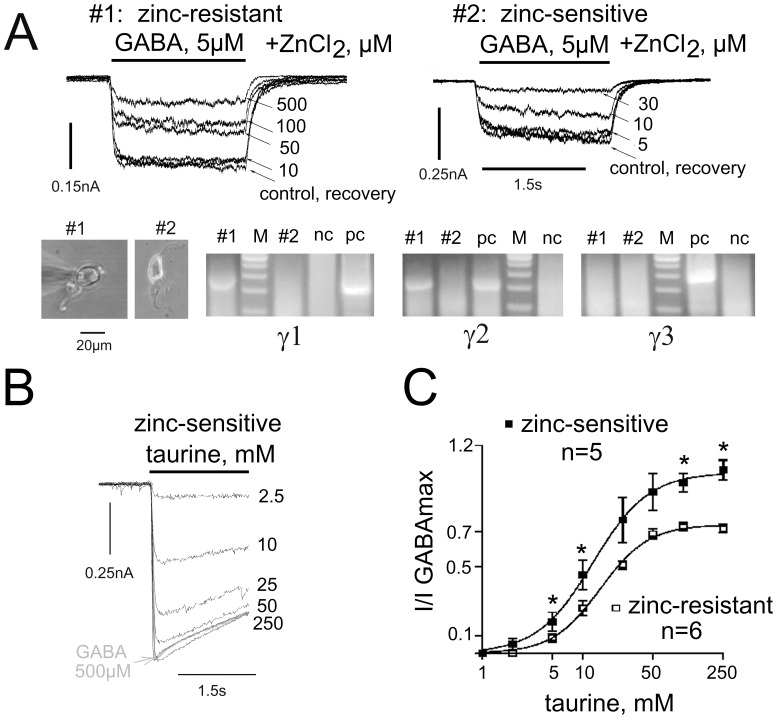
Zinc-sensitive TMN neurons show similar efficacies for GABA and taurine.(A) Zinc-inhibition of GABA-evoked currents in two representative neurons. Note that these neurons respond differently to ZnCl2 10 µM. Block of the GABA-response by this concentration served as a criterion for the selection of “zinc-sensitive” neurons. (B) Photographs of two neurons and gels illustrating single-cell RT-PCR analysis of γ-subunit (γ1–γ3) expression. Note the lack of a detectable amount of γ-subunit transcripts in zinc-sensitive cell (#2). (C) Superimposed responses to different concentrations of taurine in comparison to the maximal GABA response recorded in one zinc-sensitive neuron. (D) Averaged concentration - response plots for the two neuronal groups. Significant difference between individual data points is indicated: * = p<0.05. The maximal taurine-evoked currents represented 100±5% (filled squares, EC50 = 12.6±0.6 mM, n = 5) vs 74±2% (open squares, EC50 = 14.9±0.9 mM, n = 6) of maximal GABA-evoked currents.